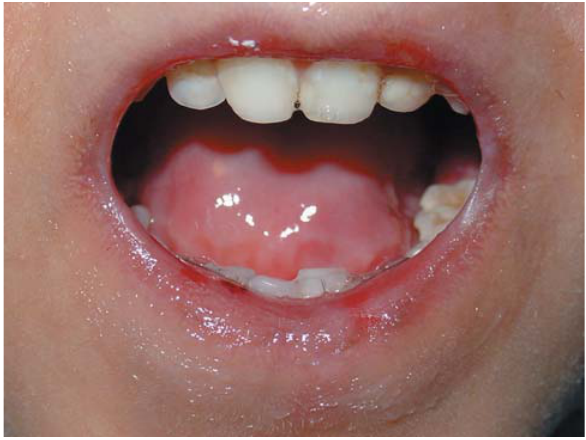
FIGURE 5- Frontal view of open mouth. The limitation of mouth opening was a consequence of the